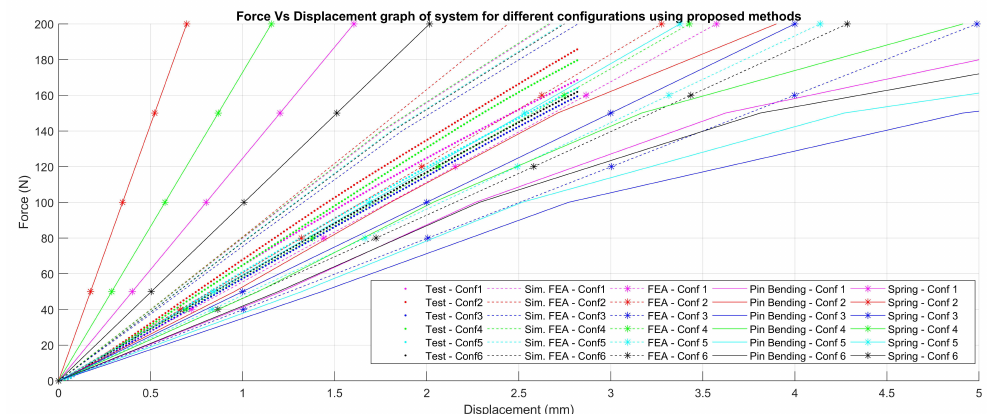
Figure 21. Predictive models versus test results. Spring Model (*-) , Simplified FEA (– ), Pin Bending Model (–), FEA (*–) and Test Results (**). Configuration 1—Magenta, Configuration 2—Red, Configuration 3—Blue, Configuration 4—Green, Configuration 5—Cyan, Configuration